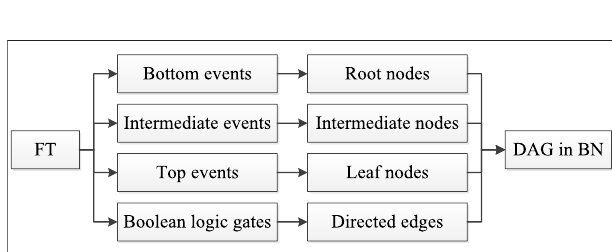
FIGURE 2 | Work fl ow of DAG construction in an FT-based BN.